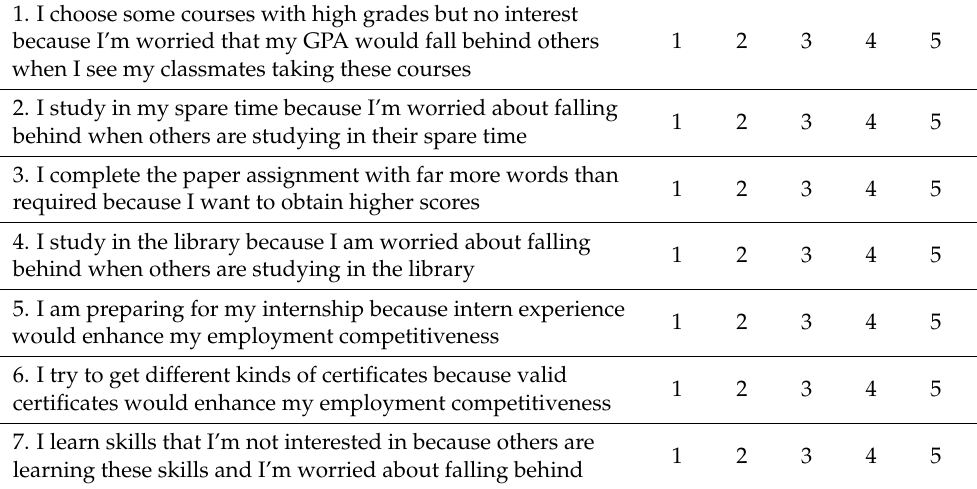
Table A2. College student involution behavior scale. Although we used the scale in Table A1 for this study, we recommend future researches using the following scale. Items are randomly scattered to avoid the potential bias in the responses. Please select the option that suits your situation according to the following description. 1 = disagree strongly, 2 = disagree somewhat, 3 = neither agree nor disagree, 4 = agree somewhat, and 5 = agree